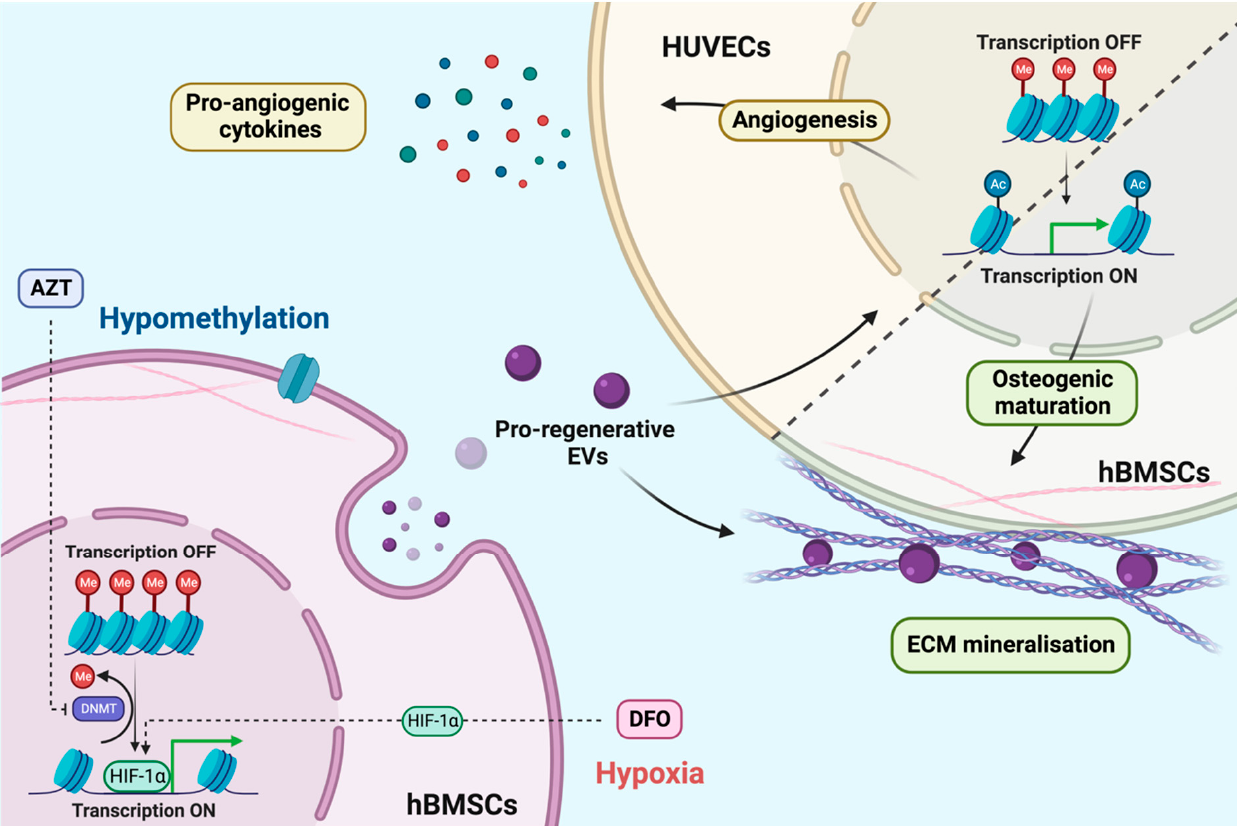
Figure 9. The schematic representation of how the mechanisms of AZT and DFO augment hypomethylation and hypoxia, enhancing the differentiation capacity of hBMSCs and the therapeutic potency of their EVs. Figure created with BioRender.com. (last assessed on 1 March 2023). Due to the clear influence of AZT and DFO on hBMSC viability, from an EV scalability